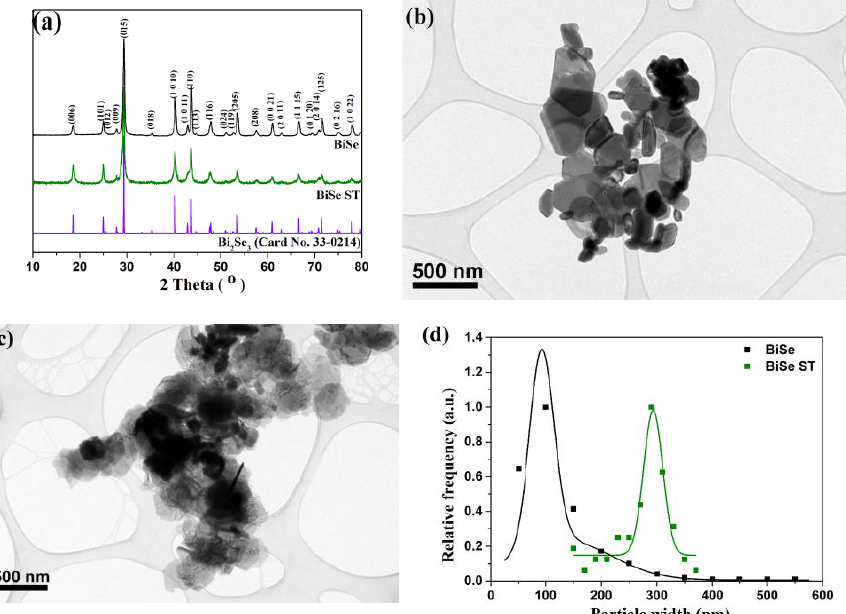
Figure 1. XRD patterns of Bi 2 Se 3 nanoparticles synthesized hydrothermally (BiSe) and solvother- mally (BiSe ST) ( a ). Representative TEM image of BiSe ( b ) and BiSe-ST ( c ) nanoparticles, and the corresponding size distribution ( d ), obtained from TEM images.